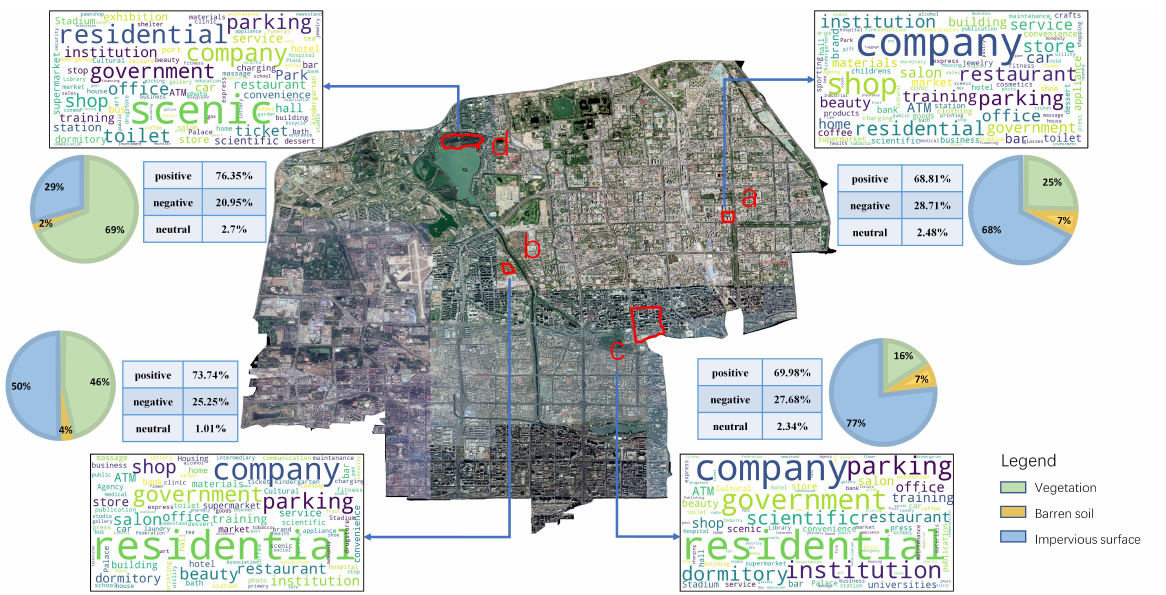
Figure 8. Portraits of typical urban functional zones. From block ( a ) to block ( d ), they are commercial zone, residential zone, public service zone, and urban green space